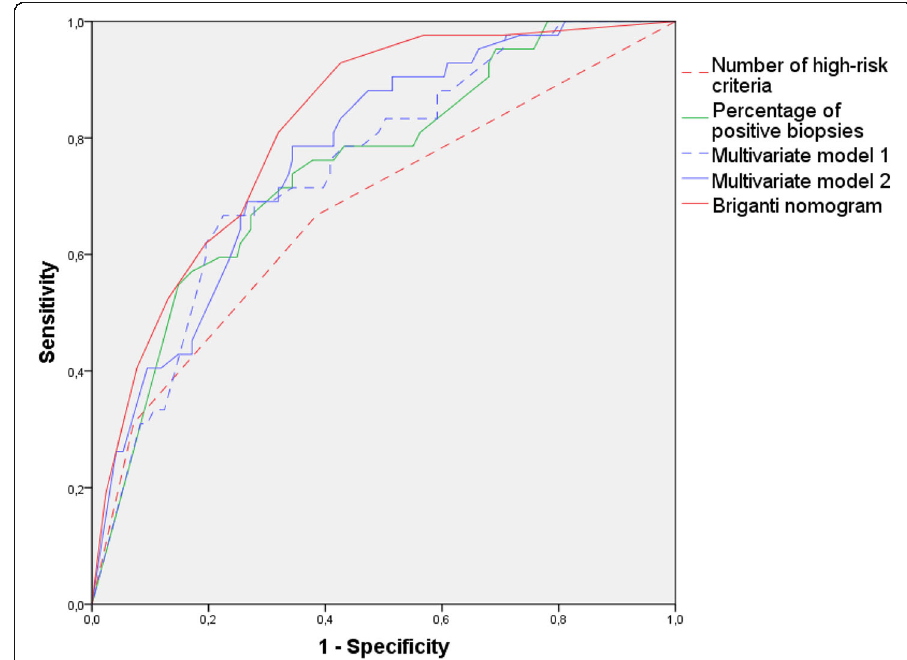
Fig. 2 Receiver-operator characteristics of the evaluated models